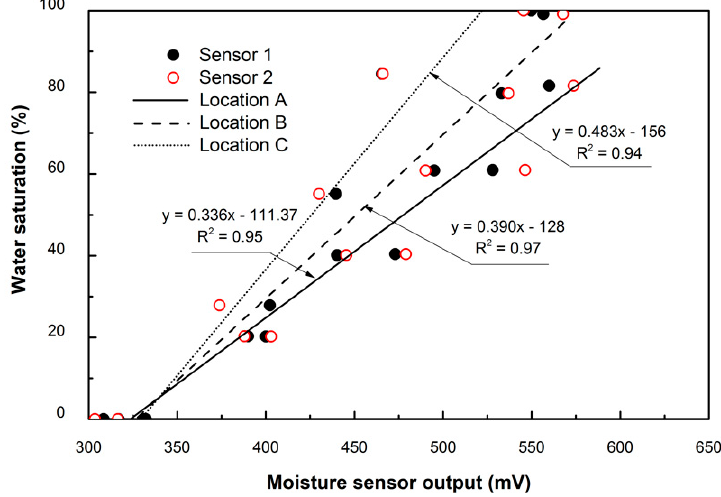
Figure 3. Calibrated results of water saturation at three locations ( A, B , and C ) using two sensors.